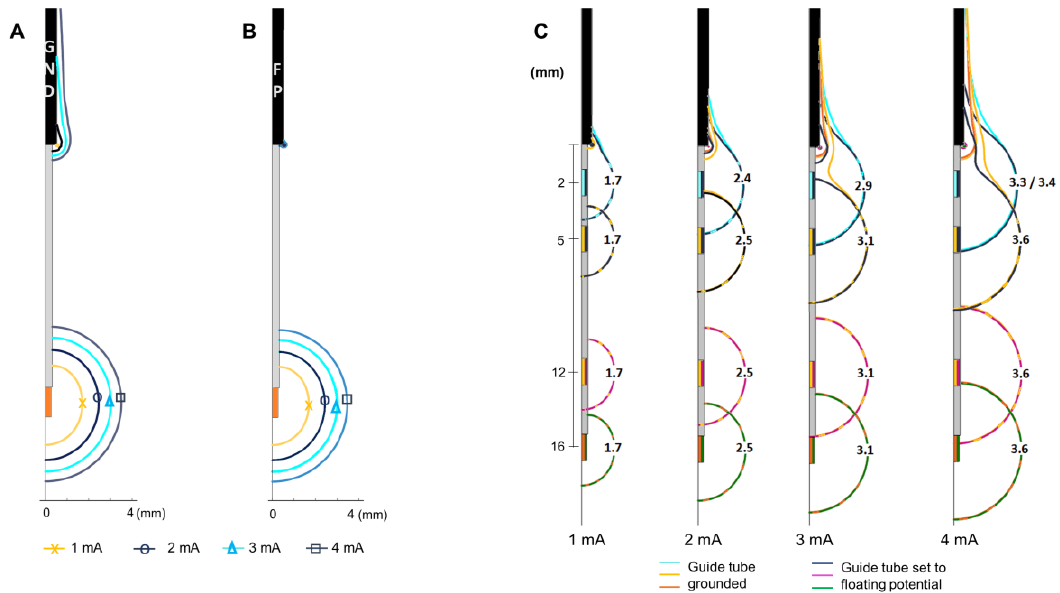
Figure 2. Influence of grounding the guide tube. Electric field (EF) isocontours (0.2 V/mm) simulated in homogeneous grey matter setting the MER stimulation contact to 1 to 4 mA in 1 mA steps. ( A ) Guide tube at target position set to ground (GND), ( B ) guide tube set to floating potential (FP), outer boundaries of the model set to ground. ( C ) EF isocontours overlapped to compare the EF when the guide tube is grounded and set to floating potential. EF simulated placing the MER electrode at different distances from the guide tube (distance to target: +4 mm, 0 mm, − 7 mm, − 10 mm) exemplified for amplitudes between 1 to 4 mA. Numbers in front of the active contact indicate the maximum distance of the isocontour to the lead axis.